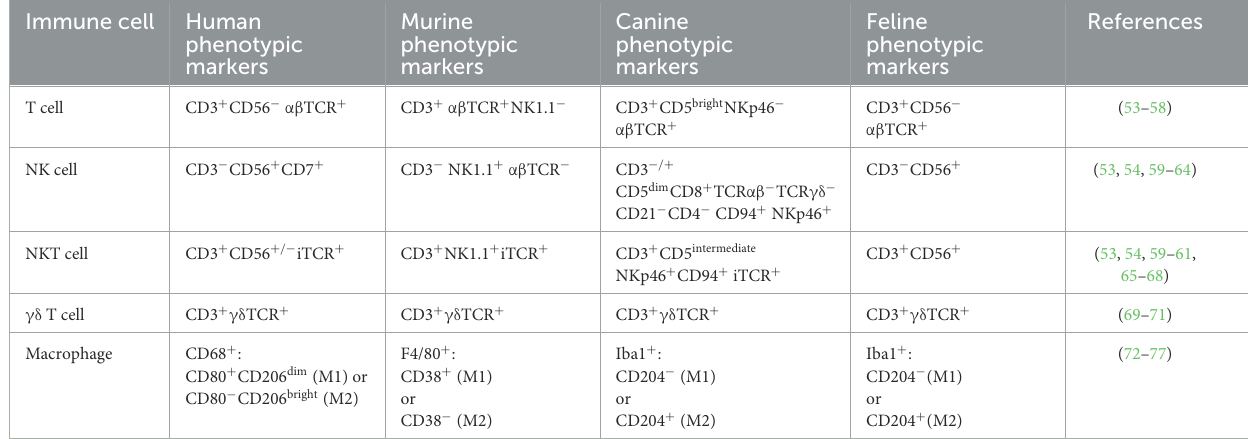
TABLE 1 Summary of species-specific surface markers that define immune cells and can be used to enrich desired populations through FACS or magnetic bead enrichment. Immune